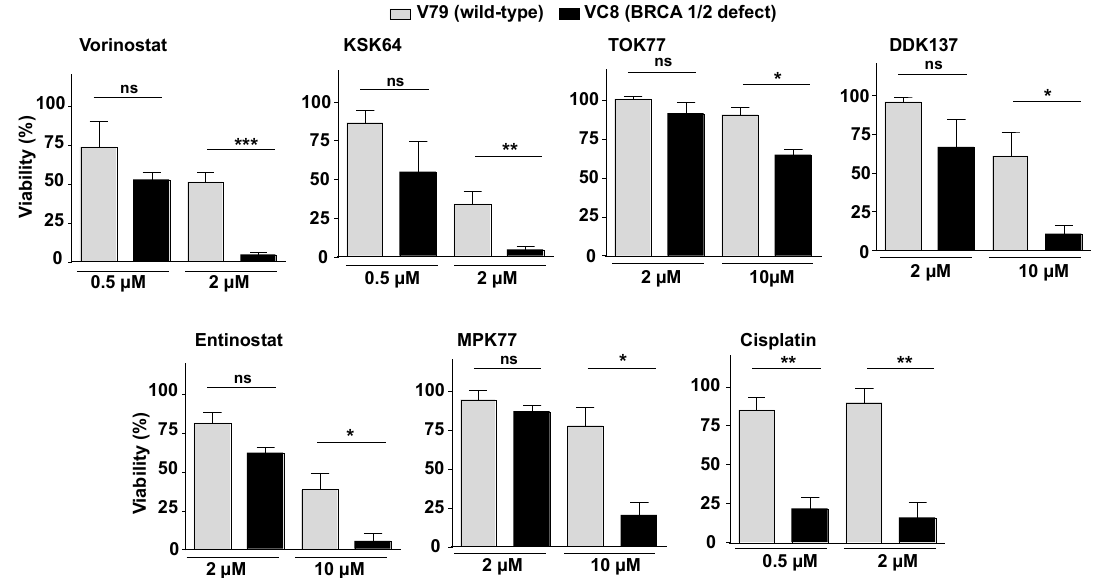
Figure 6. Sensitivity of DSB repair defective cells to hydroxamic acid- and benzamide-type HDACi. Viability of wild-type V79 cells and hamster mutant cells (VC8) that are deficient in DSB repair by homologous recombination (HR) due to a BRCA1/2 defect was analyzed 72 h after addition of HDACi by the Alamar blue assay, as described in Methods. The DNA intrastrand cross-linking agent cisplatin was used for control. Data shown are the mean ± SD from three independent experiments (n = 3) each performed in triplicate (N = 3); ns, not significant; *, p ≤ 0.05; **, p ≤ 0.01 as compared to the corresponding controls (Student´s t-test).